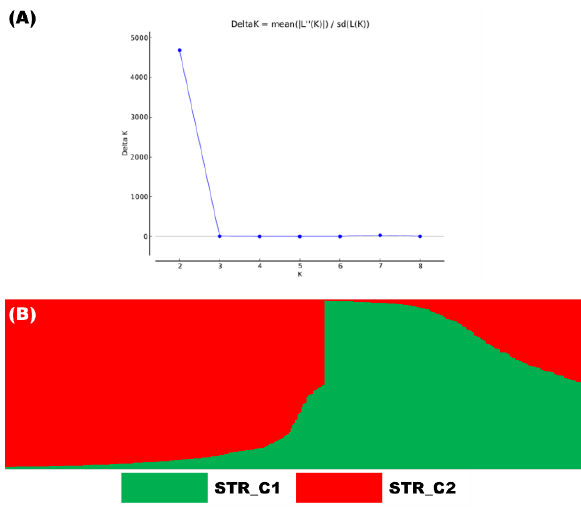
Figure 2. Model-based populations in association panels consisted of 462 tea accessions: ( A ) Delta K values for different numbers of populations (K) assumed in analysis completed with the STRUCTURE software ( B ) Classification of 462 tea accessions into two populations using STRUCTURE Version 2.3.4, where the numbers on the y-axis show the subgroup membership, and the x-axis shows the different accession. The distribution of accessions into different populations is indicated by the color coding (Cluster 1, STR_C1, is red round; and Cluster 2, STR_C2, is green). Agronomy 2020 , 10 , x FOR PEER REVIEW